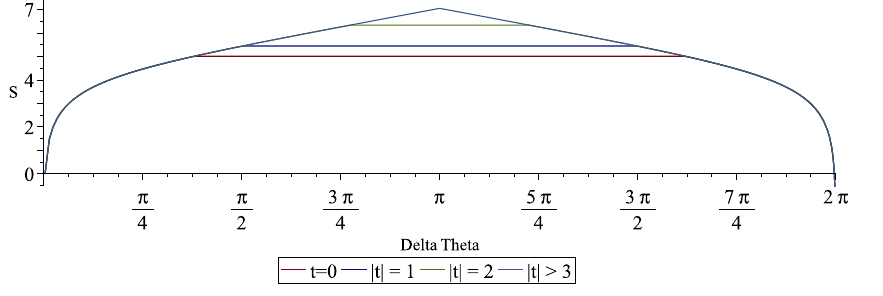
Figure 14 . Regulated entanglement entropy as a function of interval size for T = 0 : 5, r H = 2 L AdS , (cid:15) = 0 : 01. Plots from bottom to top show successively later times starting at t =